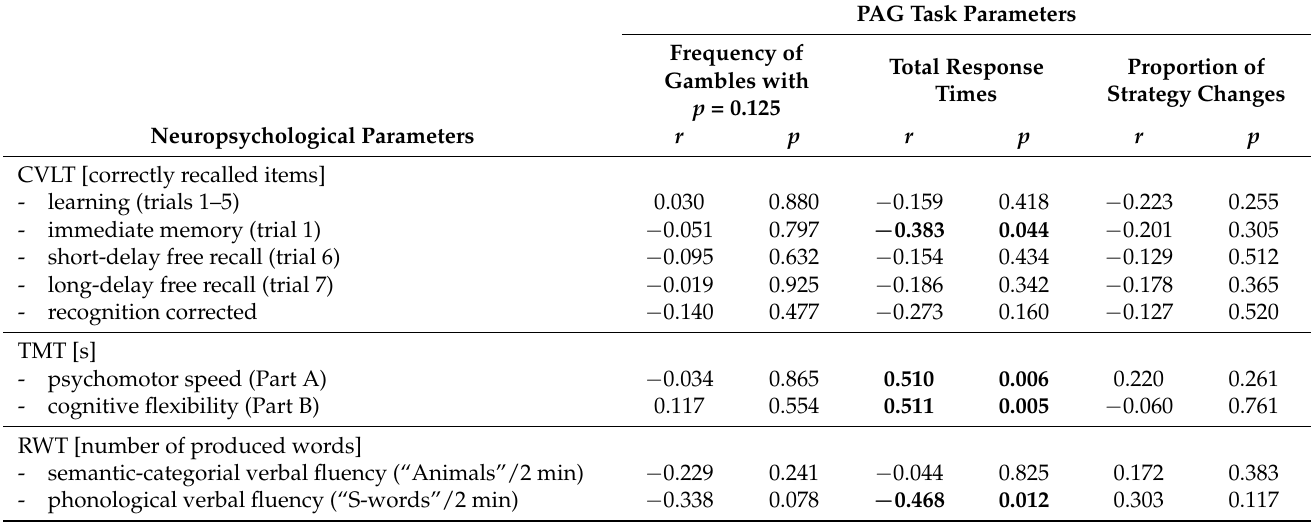
Table 5. Pearson’s correlations between decision making performance and neuropsychological background scores in patients with major depression (n = 28).